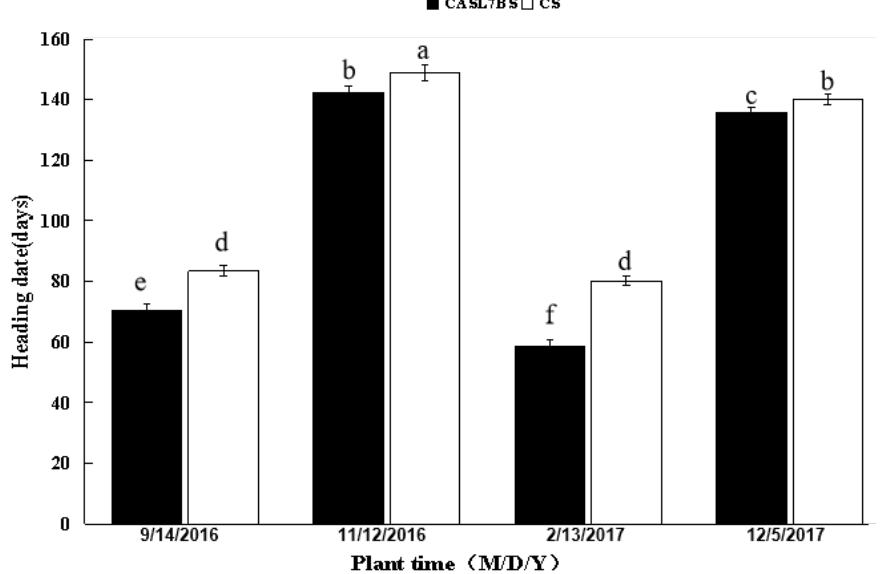
Figure 3. Heading date of CASL7BS and Chinese Spring (CS) planted in greenhouse and field in 2016, growth room, and field in 2017. Letters on the columns indicate the significance of HD difference at p < 0.05.